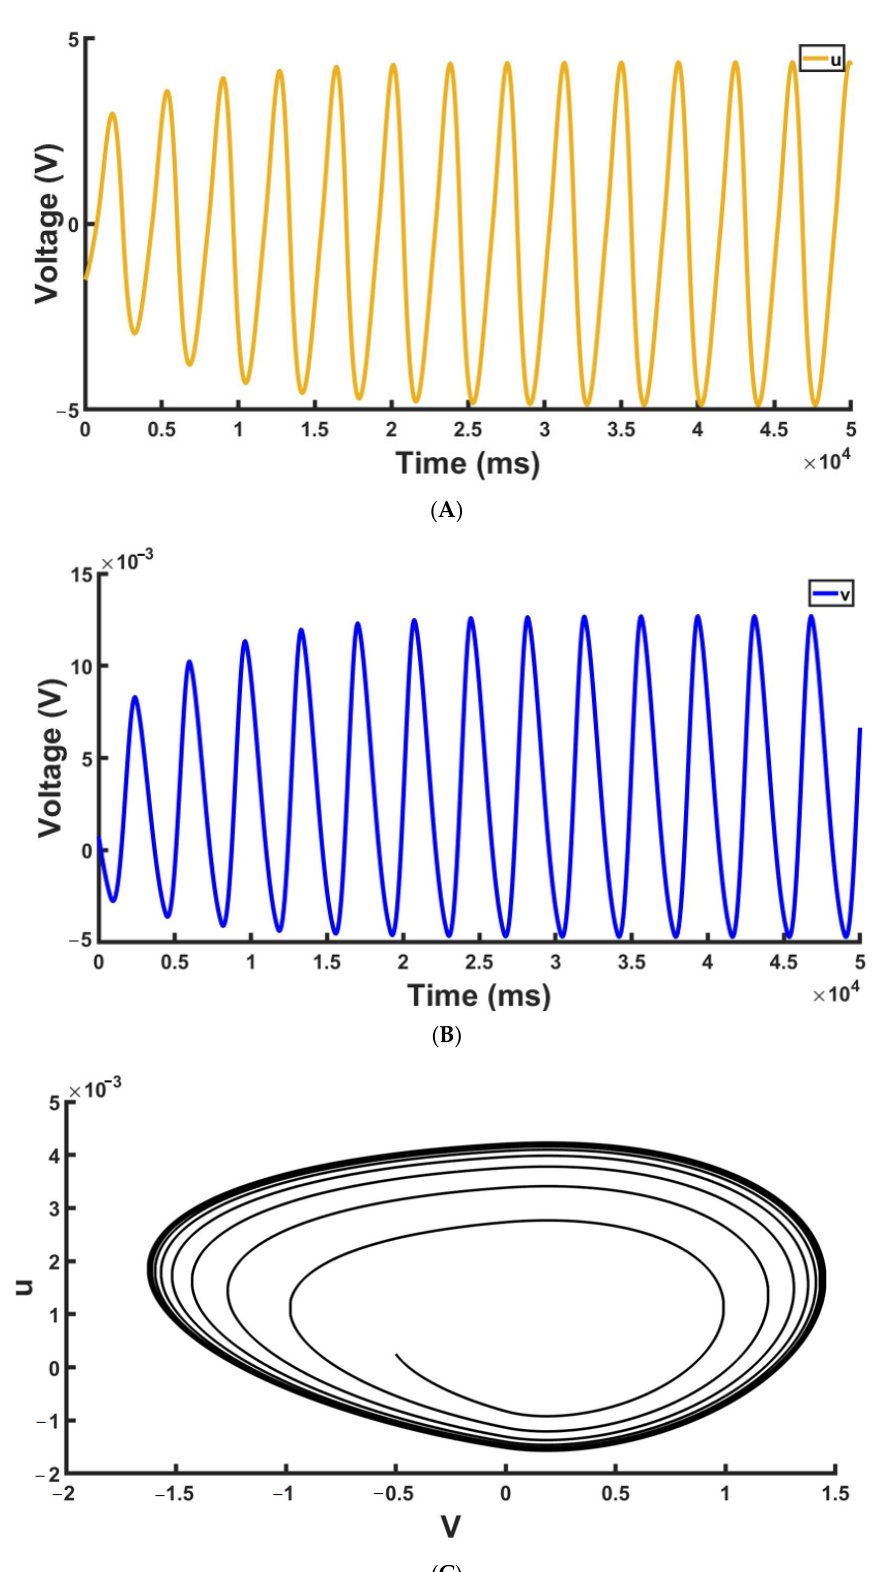
Figure 8. Results of numerical simulation of the system in the periodic generation mode: ( A ) time series u , ( B ) time series v , ( C ) phase portraits, η = 0.48, ε = 0.000024. Detailed information about the receipt of these figures is contained in Supplementary